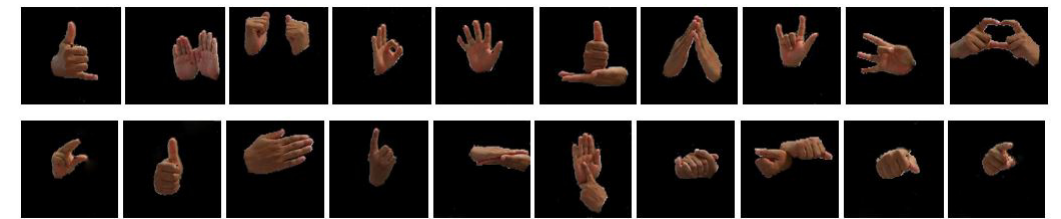
Figure 10. Example of the SkinMask segmented images from the datasets.